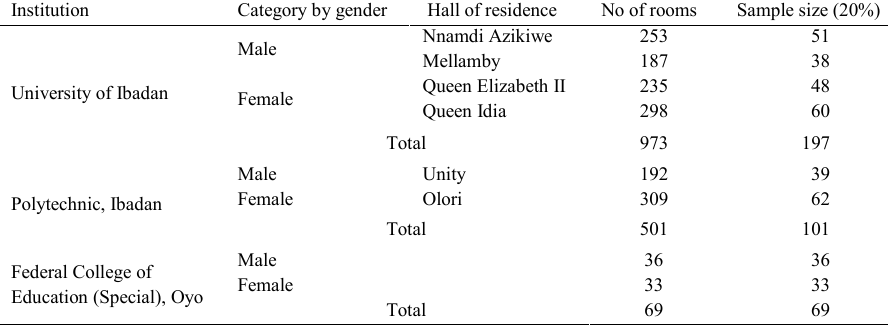
Table 1: Sample size based on the categories and capacities of selected halls of residence Institution Category by